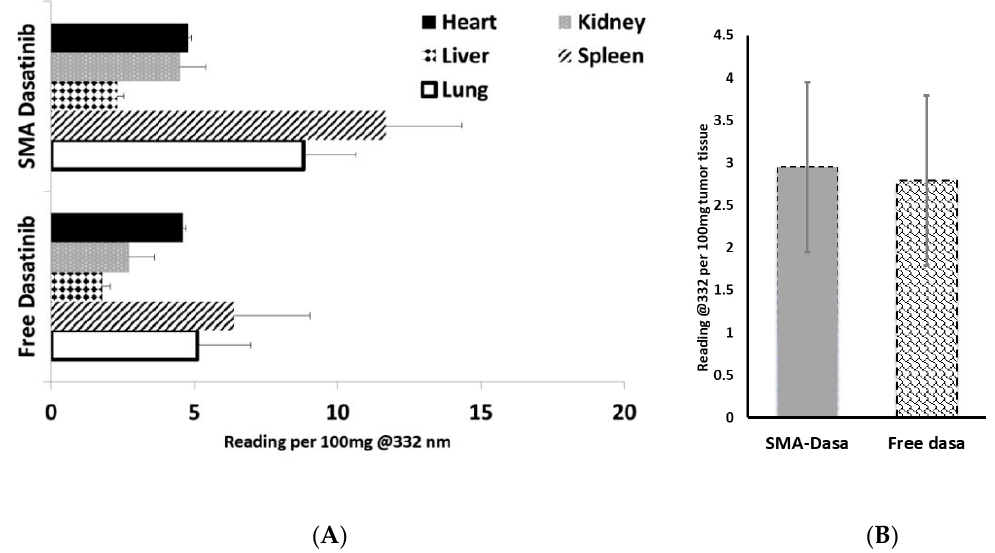
Figure 4. ( A ) Tissue and ( B ) tumor distribution of free dasatinib and SMA–dasatinib at 24 h after intravenous injection of dasatinib or SMA–dasatinib (50 mg/kg) to Balb/c mice bearing 4T1 tumors ( n = 5). Representation of the relative content of dasatinib per 100 mg tissue expressed in free and micellar